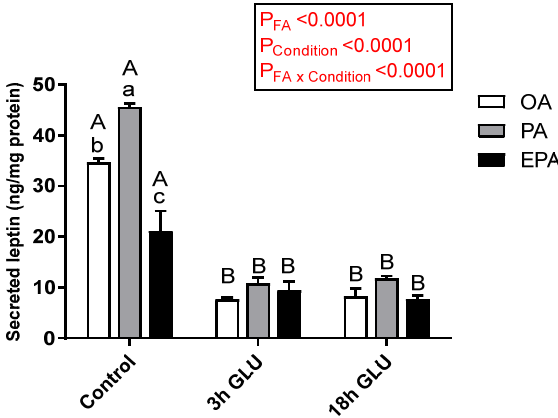
Figure 4. Changes in leptin secretion in the medium from mature Atlantic salmon adipocytes incubated with oleic, palmitic, or eicosapentaenoic acid for 72 h (Control) and serum-deprived in the presence of glucagon thereafter for 3 (3 h GLU) and 18 h (18 h GLU). Data are shown as mean ± SEM ( n = 3). Results are compared by two-way ANOVA using the fatty acid tested (OA, PA, and EPA) and the experimental condition (Control, 3 h GLU, and 18 h GLU) as factors. Lowercase letters indicate significant di ff erences between fatty acids, and capital letters indicate significant di ff erences between conditions ( p < 0.05; Tukey’s post hoc test). OA = oleic acid, PA = palmitic acid, and EPA = eicosapentaenoic acid.